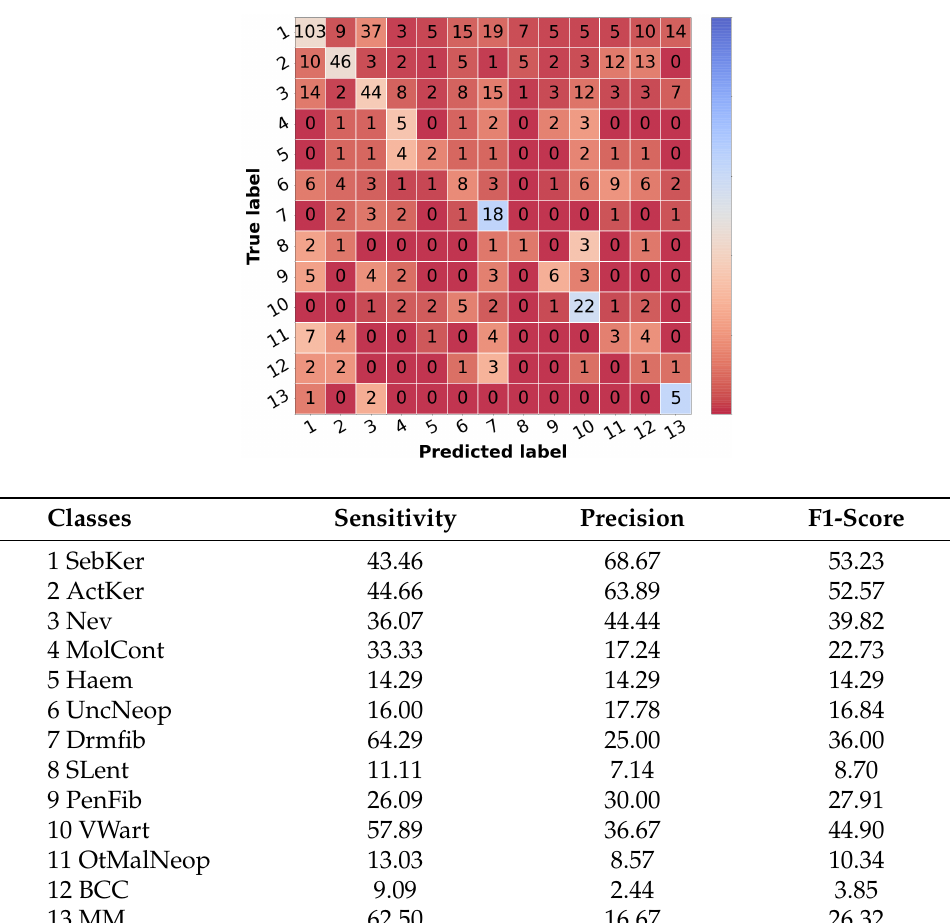
Table 4. Resulting metrics and confusion matrix of test set 1 for a differential diagnosis model trained on cropped images with 30% tolerance (in